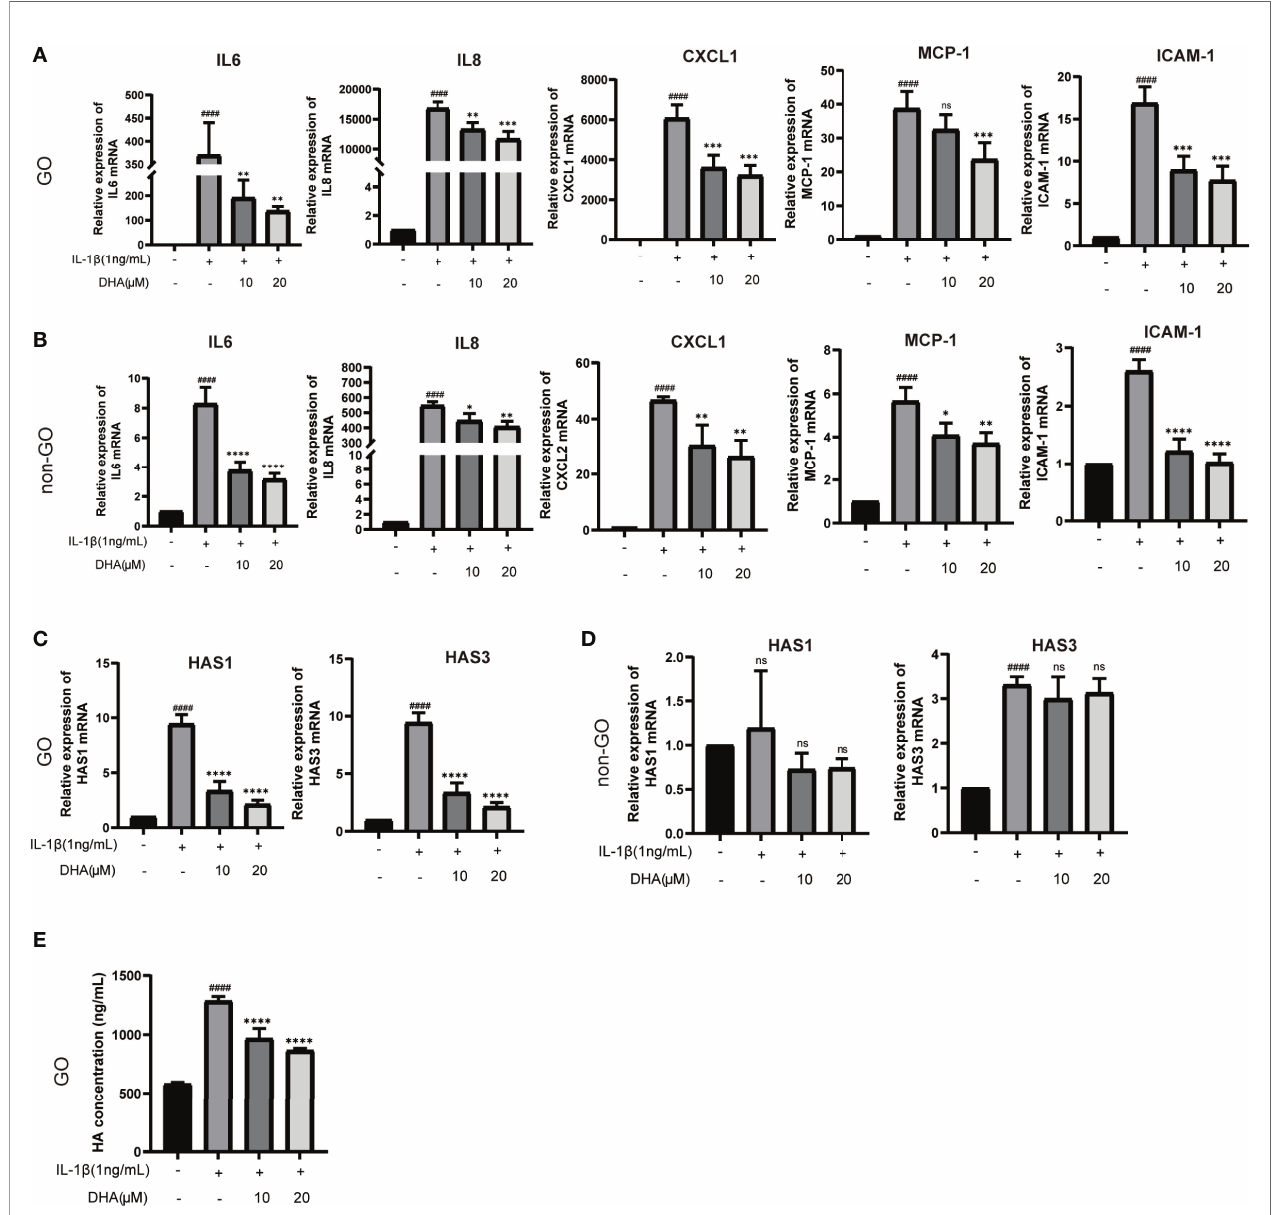
FIGURE 6 | DHA inhibits IL-1 b -Induced in fl ammation and attenuates HA production by OFs. GO OFs and non-GO OFs were stimulated with IL-1 b (1 ng/mL,24 h) with or without a 3-h pretreatment with DHA (10, 20 m M). (A, B) The mRNA levels of IL-6, IL-8, CXCL1, MCP-1, and ICAM-1 were detected by qRT-PCR (n = 3). (C, D) The mRNA expression levels of HAS1 and HAS3 were detected by qRT-PCR (n = 3). (E) The concentrations of HA in the GO-derived cell culture supernatants were quanti fi ed by ELISA (n = 4). For (A – E) , the summarized data are reported as the mean ± standard error of the mean. #### P < 0.0001 compared with the control; *P < 0.05, **P < 0.01, ***P < 0.001, ****P < 0.0001 compared with IL-1 b alone. ns denotes no statistical signi fi cance versus the control/TGF- b